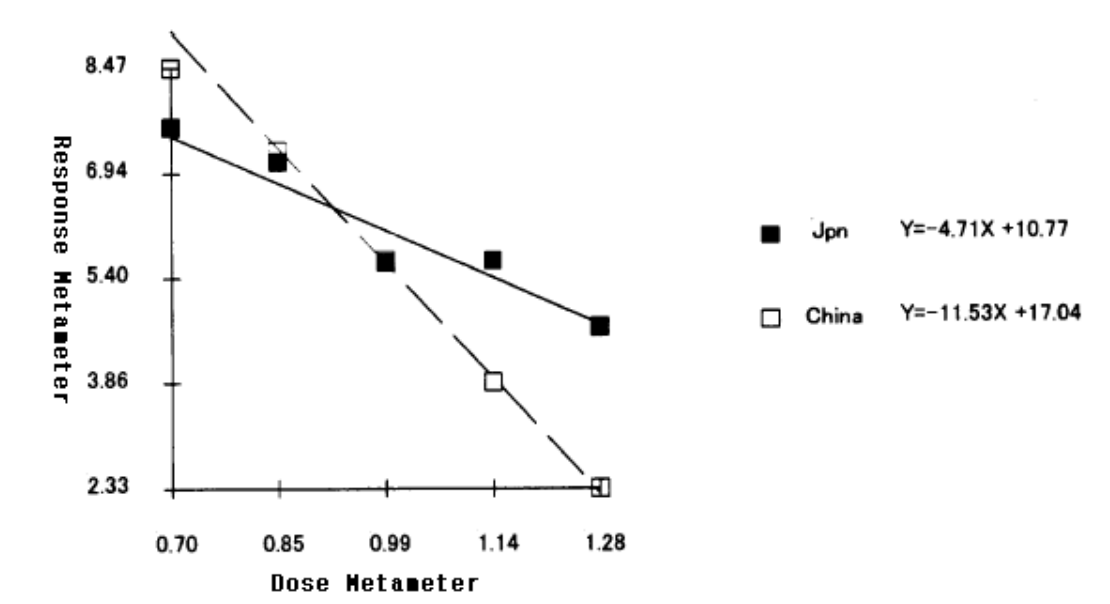
Figure 2: Median anti-lethal toxin effective dose (ED ) of Agkistrodon halys (Jpn) and 50 Jiangzhe Agkistrodon halys (China) antivenoms against 93.9 µg Jiangzhe Agkistrodon halys venom (2.4xLD ) intravenously administered to mice. 50